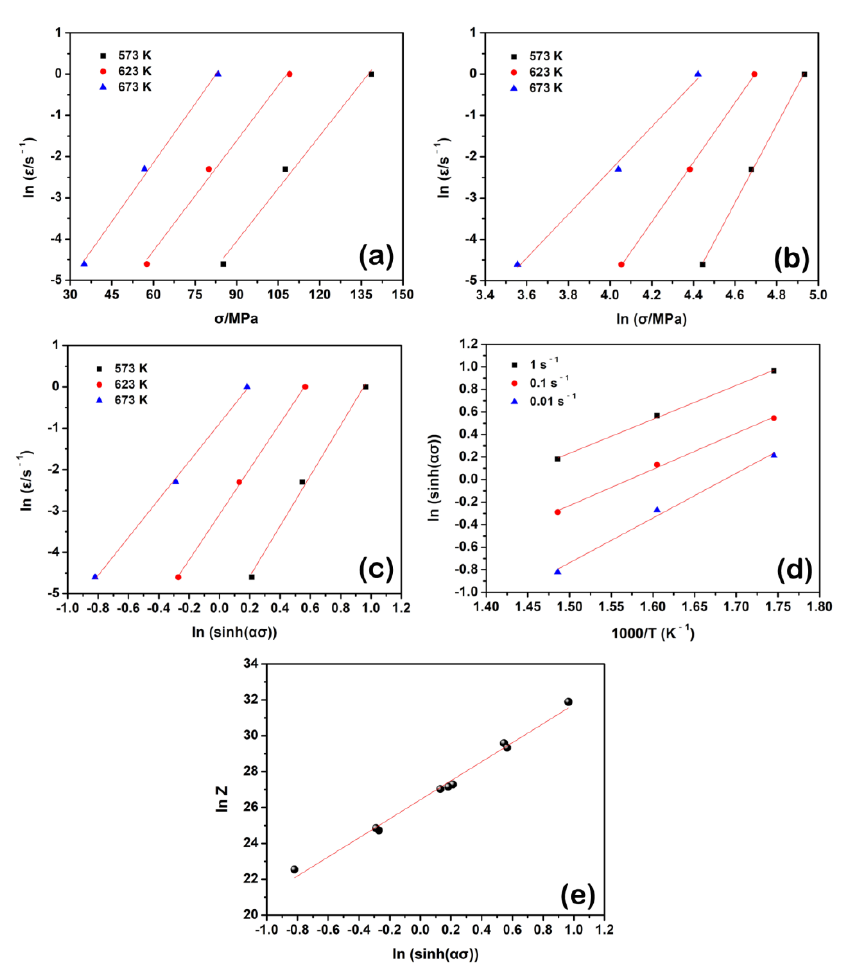
. . . (cid:1)(cid:3) (cid:2) (cid:0) sin h Figure 5. Linear relations of ( a ) ln ε − ln σ p ; ( b ) ln ε − σ p ; ( c ) ln ε − ln ασ p ; ( d ) ln [ sin h ( ασ )] − 1/ T Figure 5. Linear relations of ( a ) 𝑙𝑛𝜀̇ − 𝑙𝑛𝜎 𝑝 ; ( b ) 𝑙𝑛𝜀̇ − 𝜎 𝑝 ; ( c ) 𝑙𝑛𝜀̇ − 𝑙𝑛[𝑠𝑖𝑛⁡ℎ(𝛼𝜎 𝑝 )] ; ( d ) (cid:2) (cid:0) (cid:1)(cid:3) sin h ασ p and ( e ) lnZ − ln under the peak stress condition of the solution-treated BX31 𝑙𝑛[𝑠𝑖𝑛⁡ℎ(𝛼𝜎)] − 1/𝑇 and ( e ) 𝑙𝑛𝑍 − 𝑙𝑛[𝑠𝑖𝑛⁡ℎ(𝛼𝜎 𝑝 )] under the peak stress condition of the solu- tion-treated BX31 alloy.